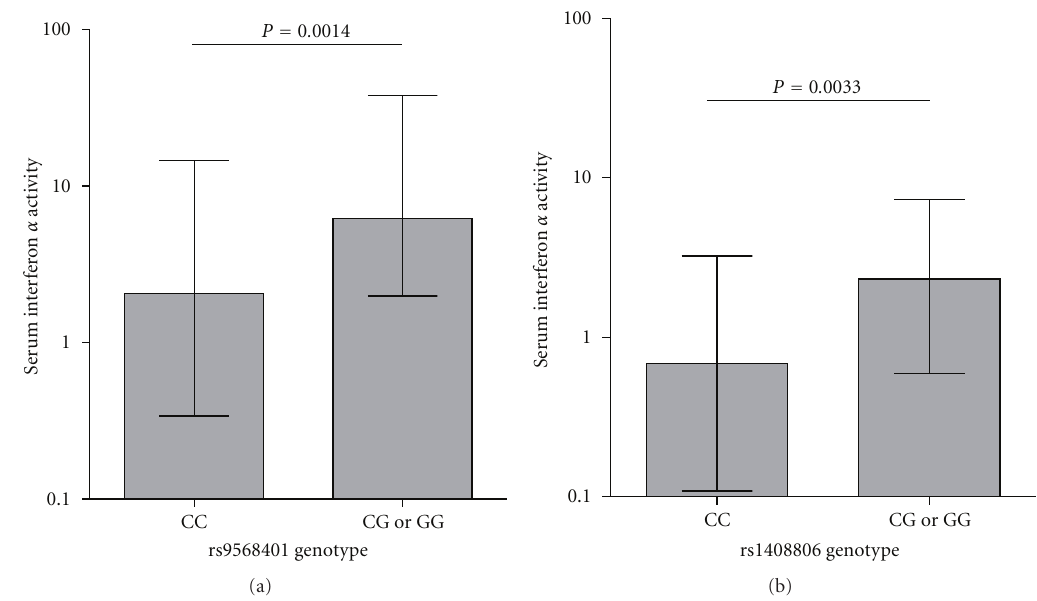
Figure 3: Serum IFN- α activity in SLE patients stratified by SNP genotype at rs9568401 (a) and rs1408806 (b). Minor allele homozygotes are combined with heterozygotes on the graph. Bars show the median error bars show the interquartile range. P value by Mann-Whitney U